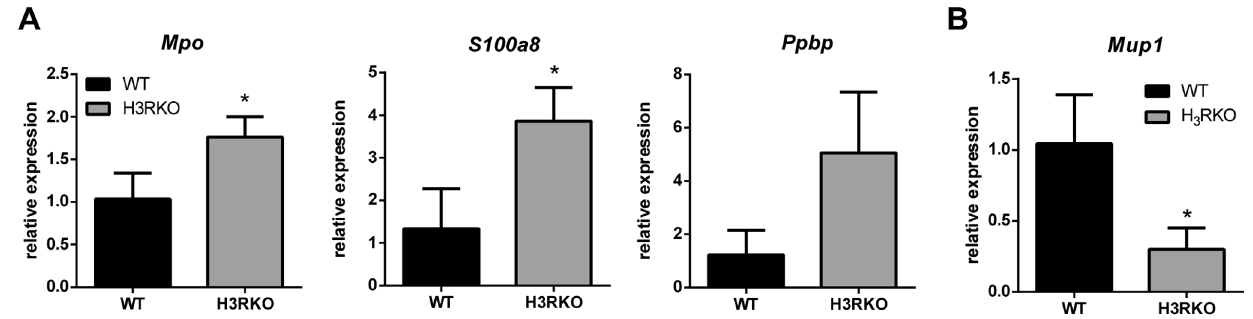
Figure 6. qRT-PCR validation of genes differentially expressed in WT and H 3 RKO LN upon CFA + PTX treatment. WT and H 3 RKO (n=3 for WT, and n=4 for H 3 RKO) mice were injected with CFA + PTX. RNA was isolated from LN 24 hours later and subjected to qRT-PCR analysis (see materials and methods) to quantify the mRNA expression of the indicated genes. Data were analyzed using unpaired parametric T test. * indicates p , 0.05 compared to